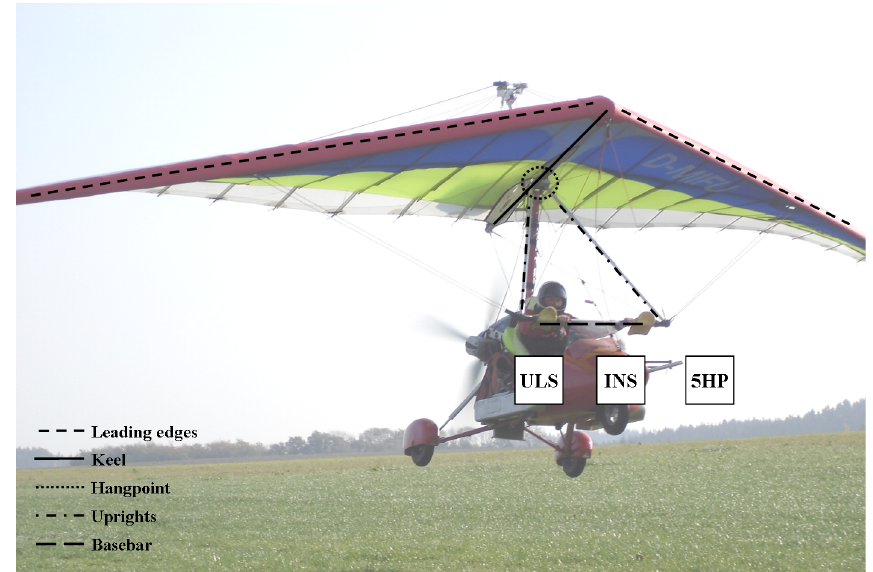
Fig. 1. Weight-shift microlight research aircraft D-MIFU, aircraft structural features are highlighted by dash-dotted lines. Sensor locations of five hole probe (5HP), inertial navigation system (INS, inside aircraft nose) and universal laser sensor (ULS, below pilot seat) are indicated. For details on the respective installations see Sect. 2.2 and Table 2. Figure 3 details the layout of the five hole probe.